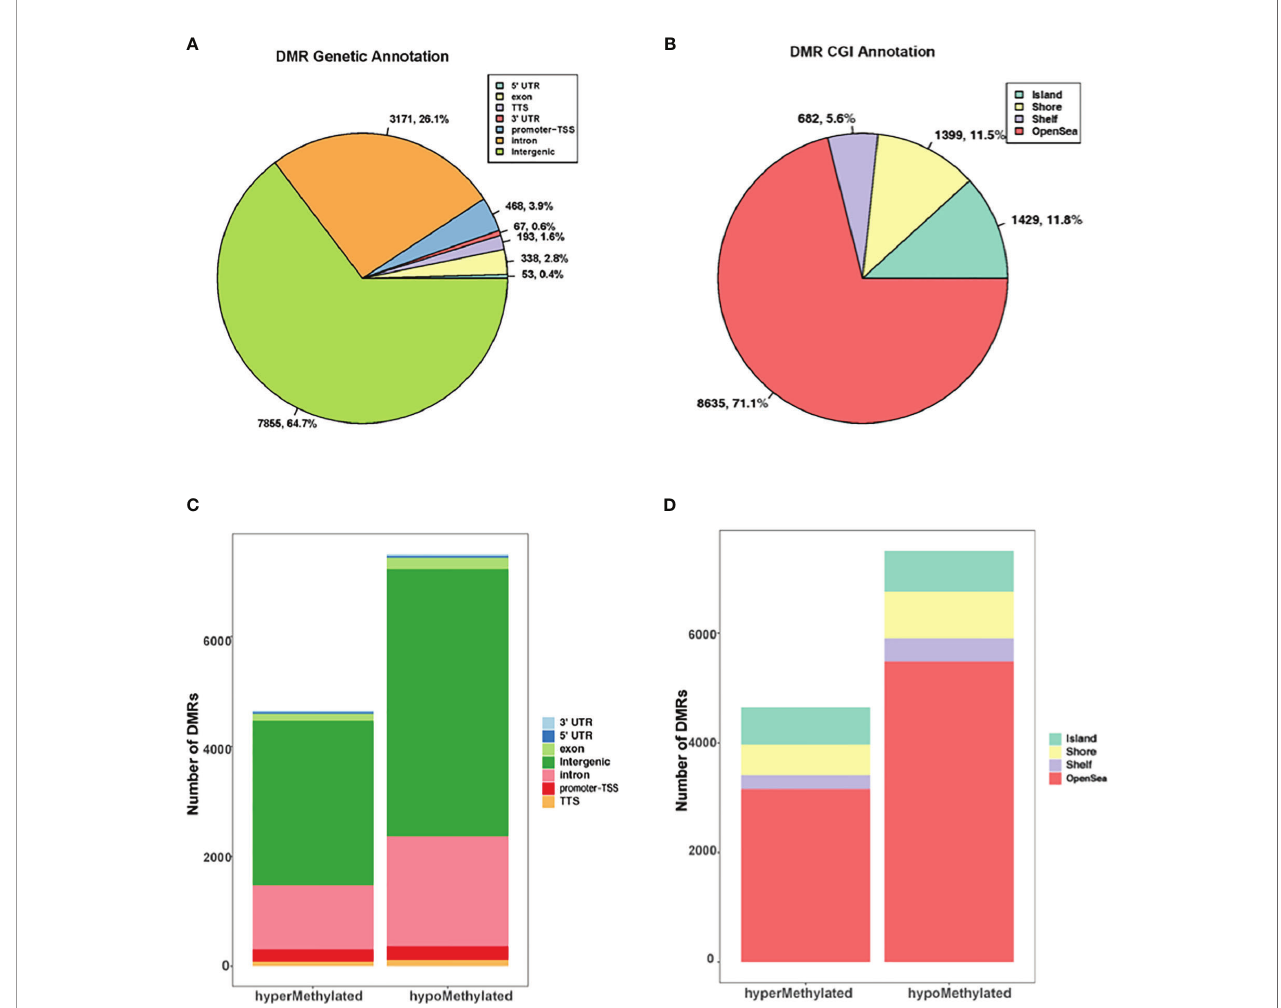
FIGURE 1 | Genome wide distribution of differentially methylated regions (DMRs). (A) The proportion of DMRs that overlap with 5 ’ UTR, exons, TTS, 3 ’ UTR, promoter-TSS, intron, and intergenic regions. (B) The proportion of DMRs with respect to CpG islands versus CpG shores (2000 bp fl anking CpG islands), shelves (2000 bp fl anking shore), and open sea regions (greater than 4 kb from CpG islands). (C) The distribution of hyper and hypomethylated regions with respect to their genetic location to genes. (D) The distribution of hyper and hypomethylated regions with respect to their distance to